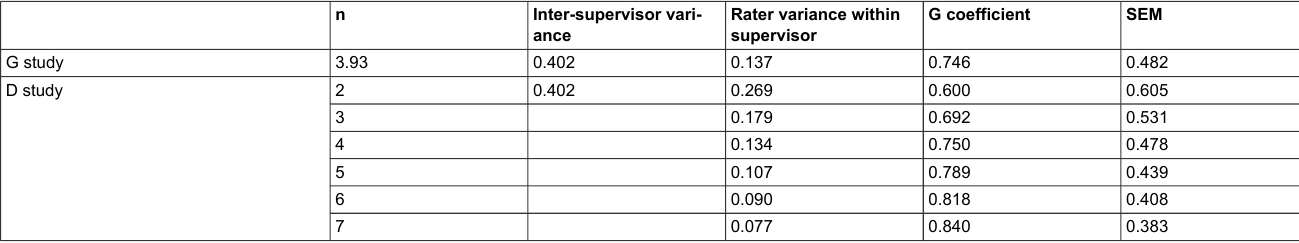
Table 4: G study and D study on inter-rater reliability.